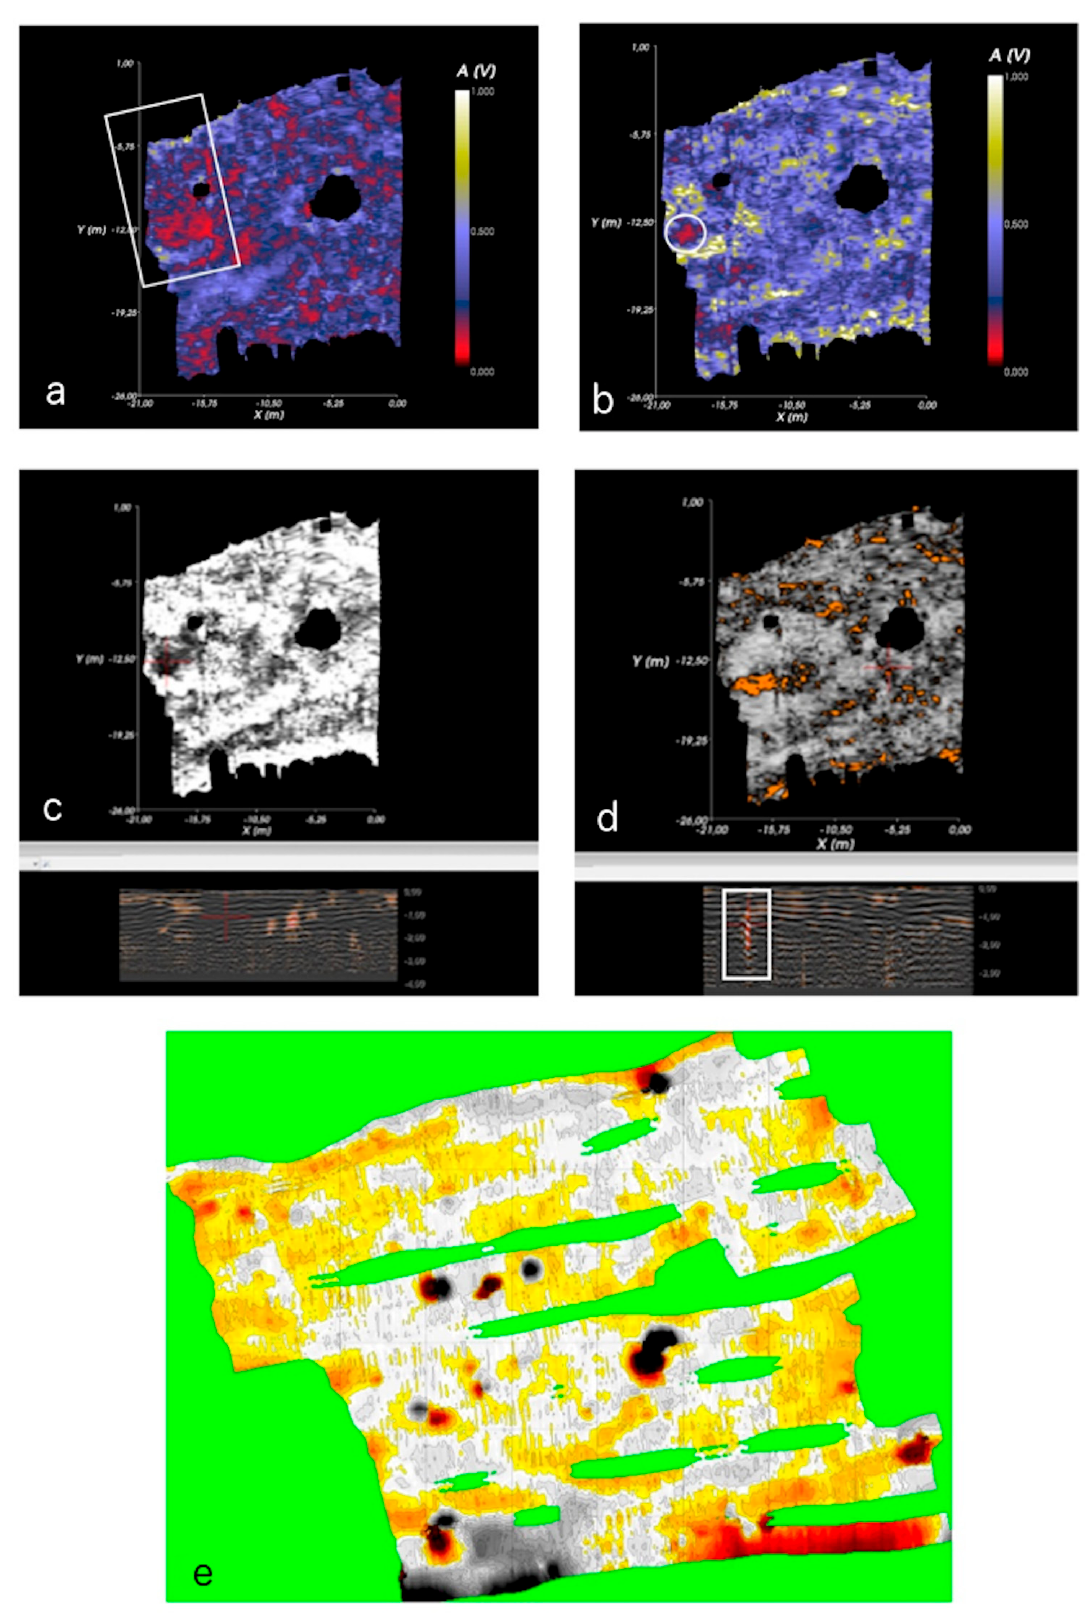
Figure 15. Details of GPR and Magnetometer scan results. ( a – d ) different visualisations of the GPR project results with indication of possible borehole (white circle and squares marked on the images); ( e ) result of the same area from themagnetometer results.